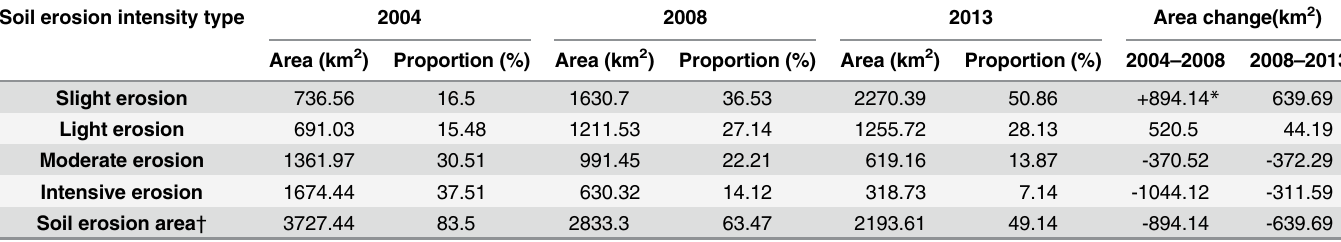
Table 2. Area change of soil erosion intensity in the ecological restoration area during different